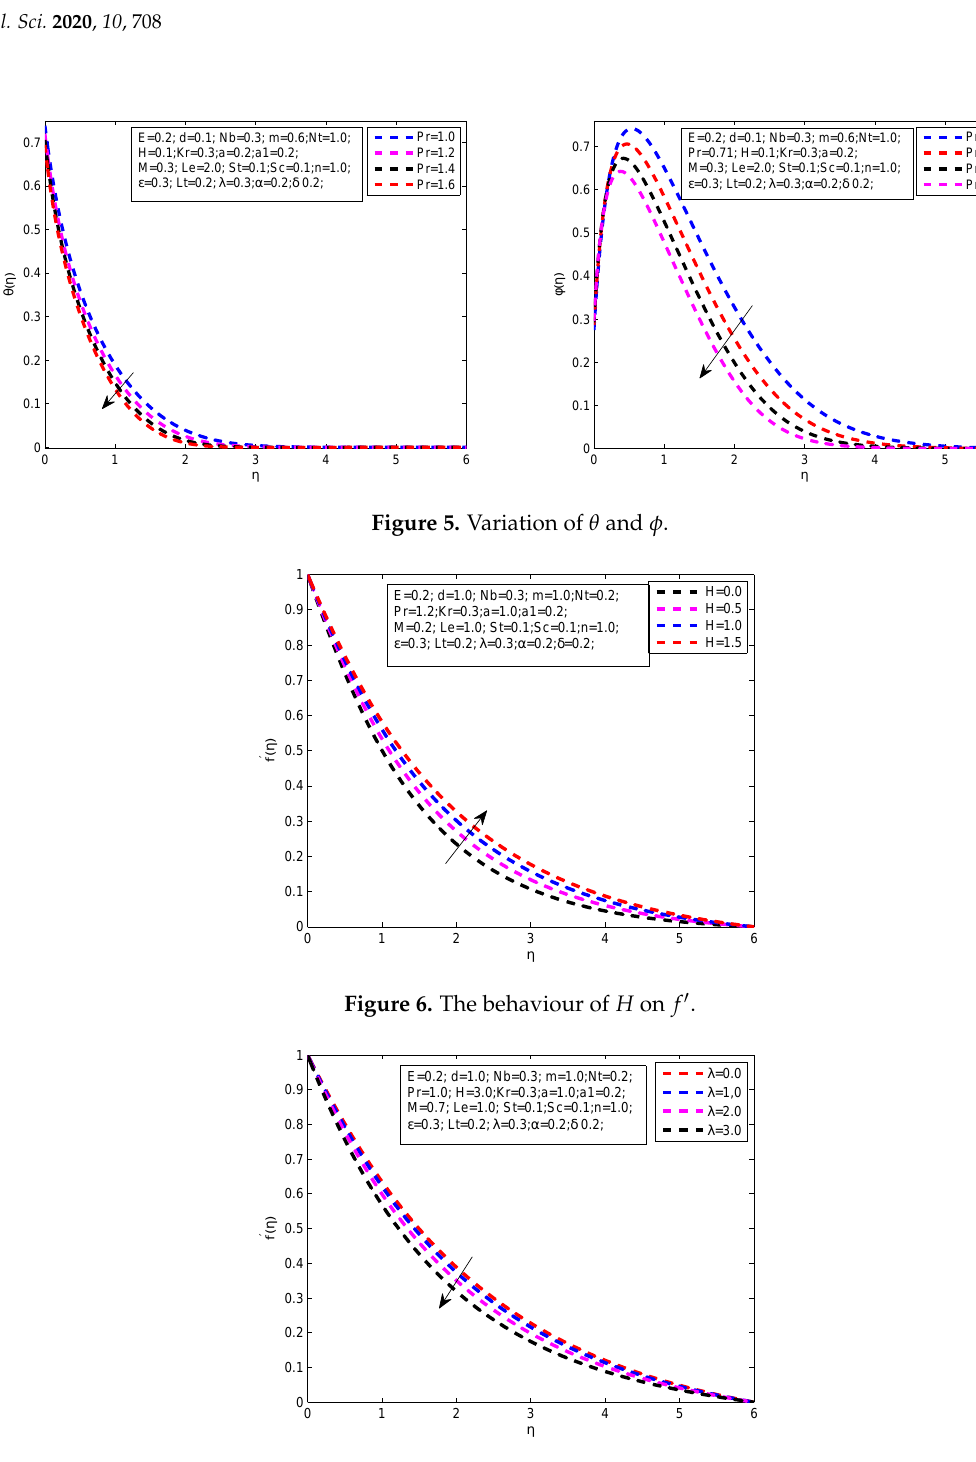
Figure 7. The behaviour of λ on f (cid:48) . Table 1. Comparison of − f (cid:48)(cid:48) ( 0 ) at H = 1.0, m = β = St = a = λ = ξ = 0. for distinct values of M with perviously published